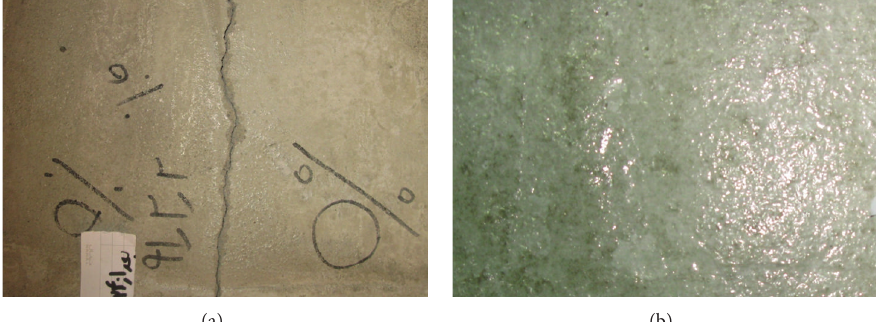
Figure 2: An example photograph of mortar surface after 24 hours. (a) Mortar without Estabragh fiber showing a crack. (b) Mortar with 0.75% Estabragh fibers showing no